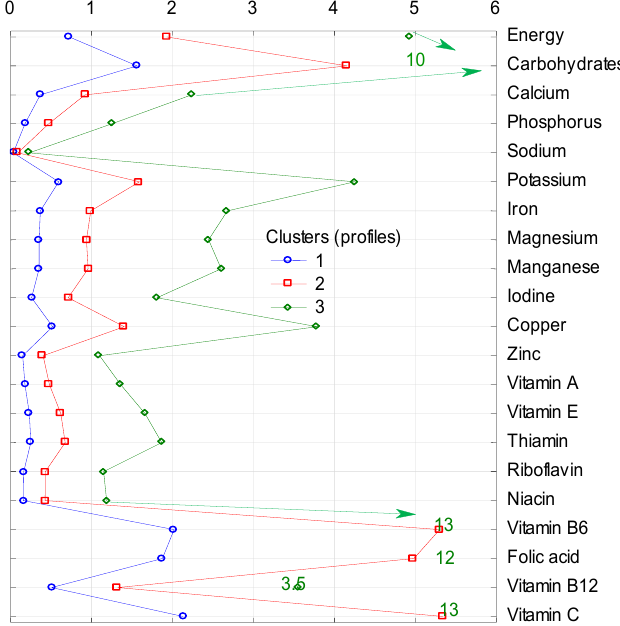
Figure 3. Cluster analysis: supply of energy and analyzed nutrients (in %) from the subgroup of other nonalcoholic beverages to diets in individual clusters. 1, 2, 3—number of clusters; characteristics of clusters are presented in Table 3.